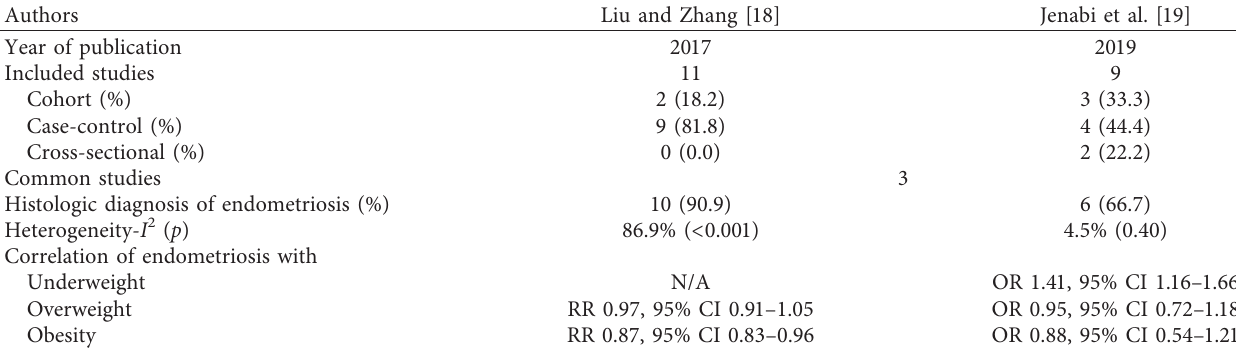
Table 1: Comparison between two meta-analyses examining the correlation between endometriosis and